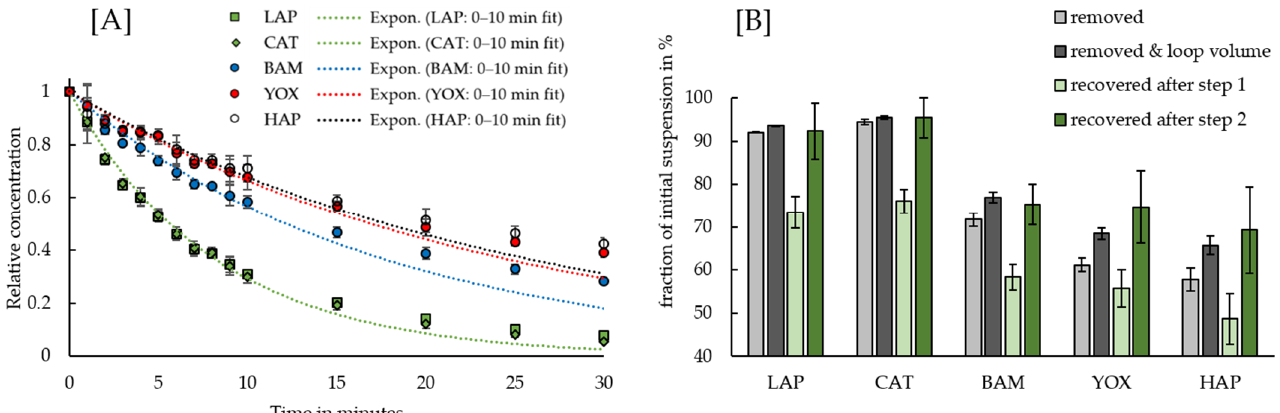
Figure 3. ( A ) Evolution of the phosphors’ RCs during the removal experiments with the HGMS. For each phosphor, an exponential regression (“Expon.”) of the type RC = e − k · t was fitted to the observations of the first 10 min. ( B ) Estimated phosphor fractions that were removed, with and without taking the loop volume into account, and recovered in a separate beaker after cleaning of the separation cell with water at a high flow rate and an intermittent air–water flow. The error bars depict one standard deviation.